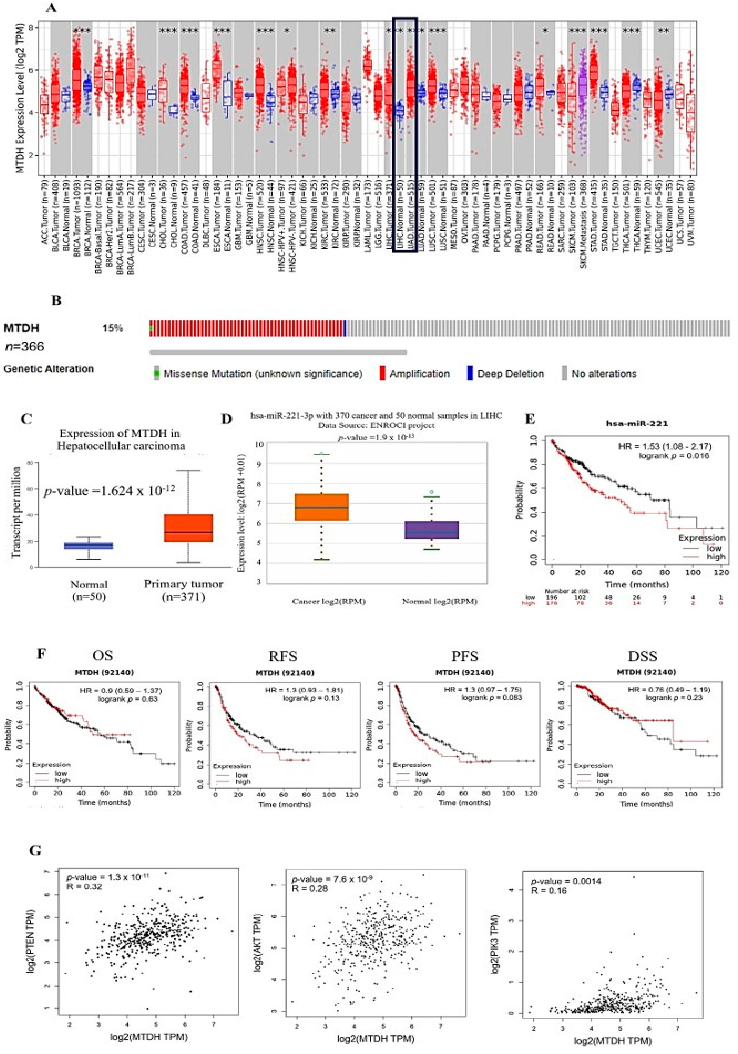
Figure 1. High expression of AEG-1 and miR-221 with poorer prognosis in liver cancer pa- tients. ( A ). The mRNA expression of AEG-1 showed across all TCGA tumors, T